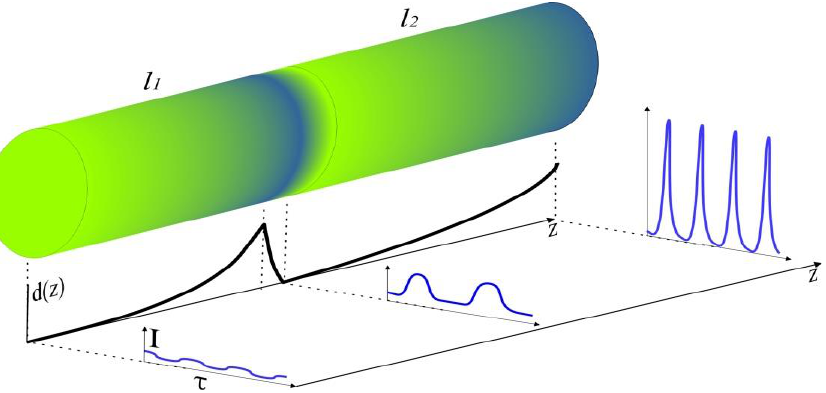
Figure 2. Schematic of USP generation in the fiber configuration comprising two nonuniform active fiber segments and conversion of the input CW signal into USP. The black curve shows the GVD profile. Optical signals propagating through the configuration are shown by blue curves.